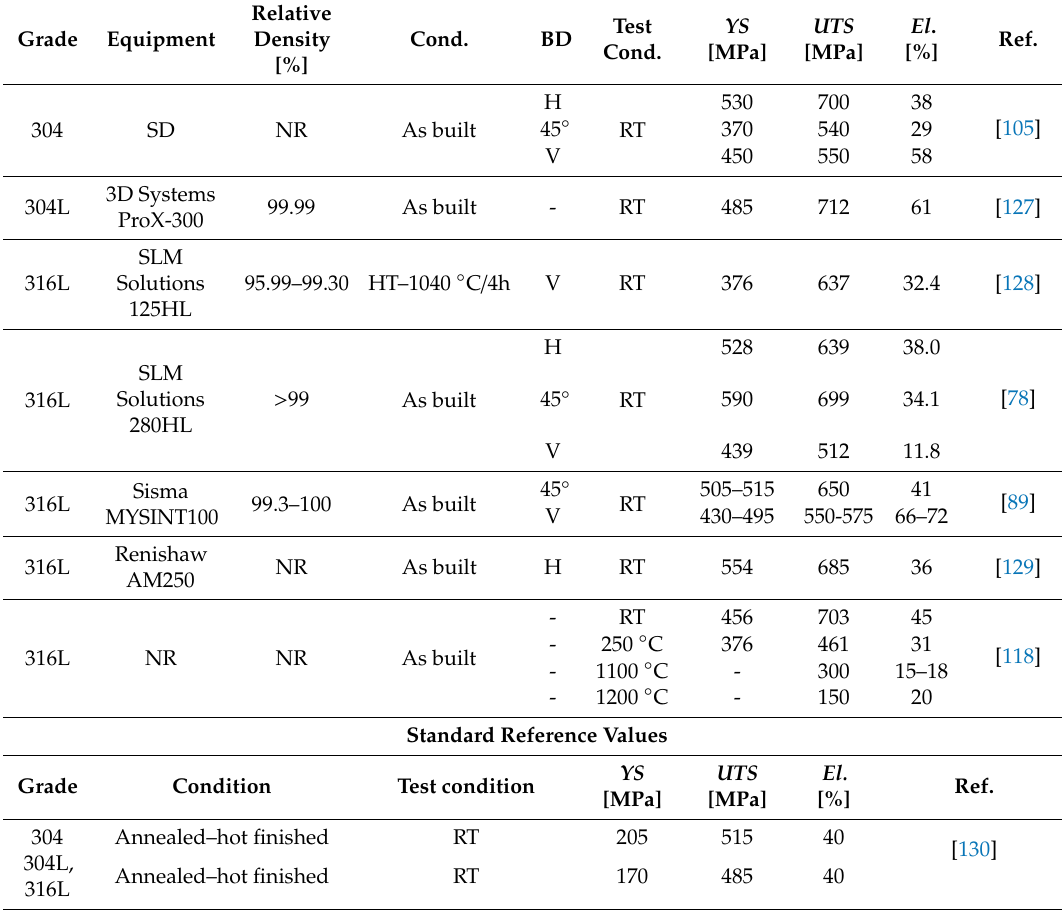
Table 2. Tensile strength of austenitic stainless steel grades obtained from L-PBF, compared to standard reference values.